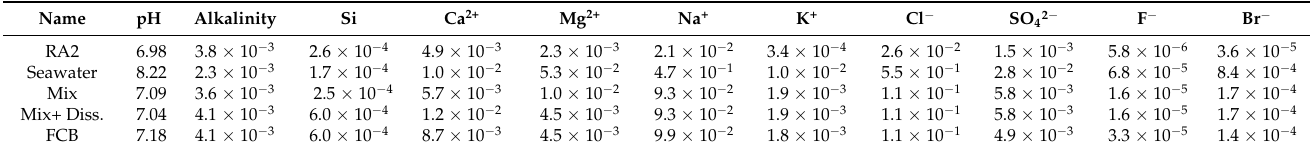
Table 5. Results of the geochemical modeling of the seawater mixing with RA2 water and reaction path processes. Units are in